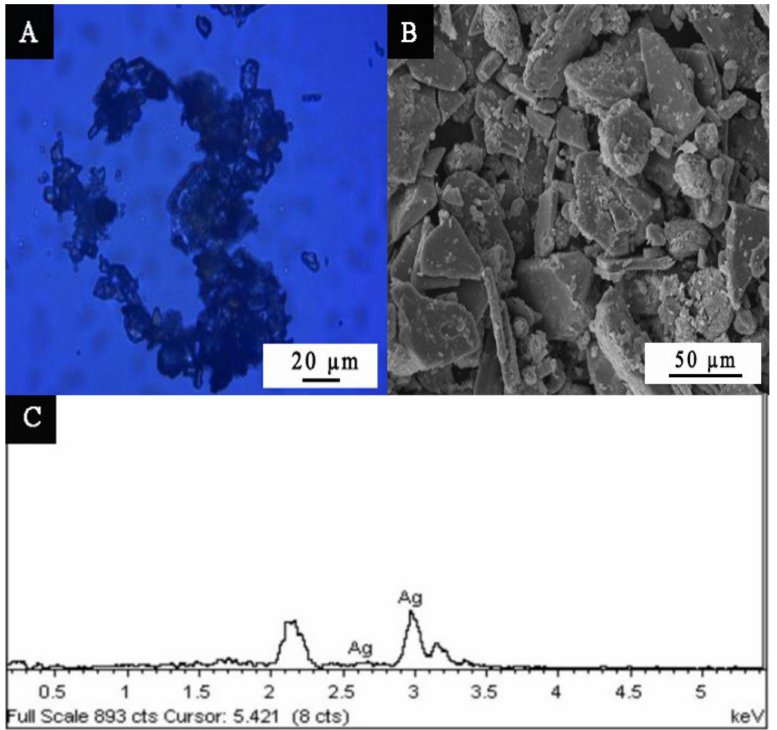
Figure 1. ( A ) OM image of micron silver particles, ( B ) SEM microscopic morphology of micron silver particles, and ( C ) EDS of micron silver